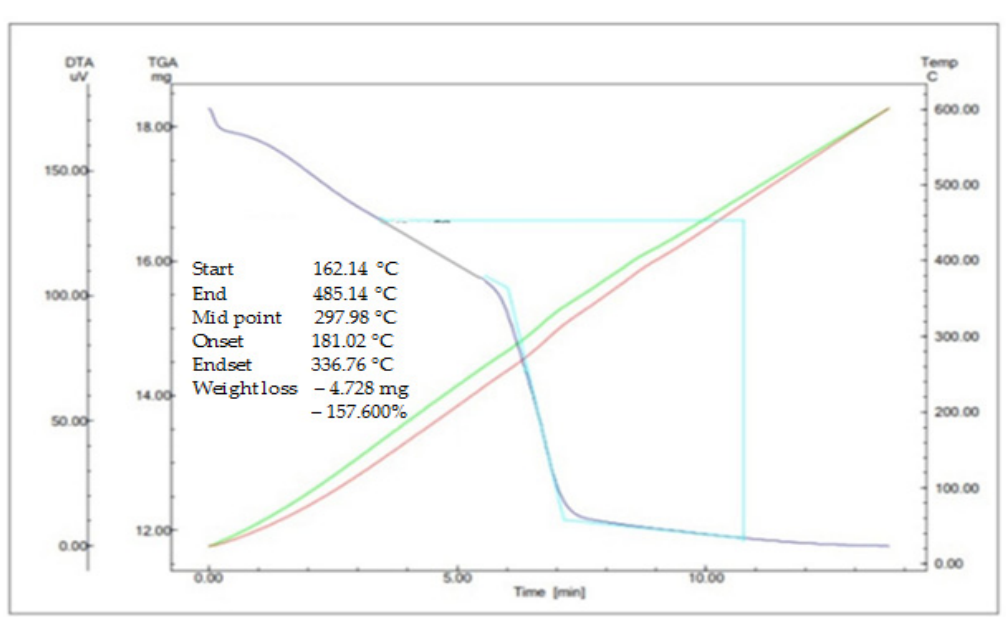
Figure 3. TGA analysis on biofilms to investigate sample resistance at a high temperature range before being applied as a food packaging .